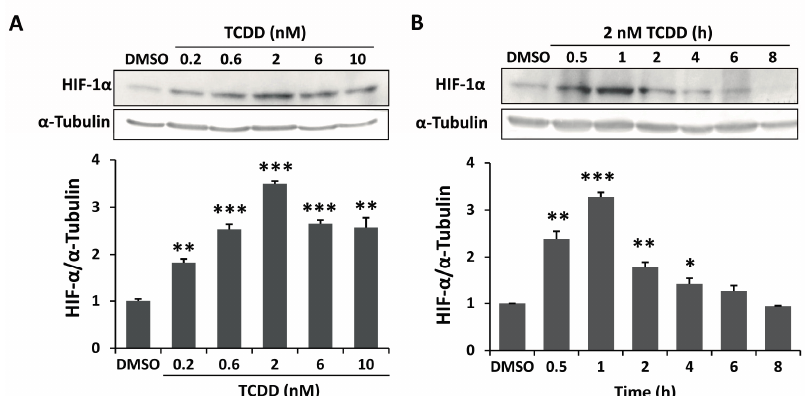
Figure 1. Dose- and time-dependent effects of 2,3,7,8-Tetrachlorodibenzo- p -dioxin (TCDD) on hypoxia-inducible factor-1 alpha (HIF-1 α ) stabilization in human trophoblastic cells. Western blots of a representative experiment were shown. ( A ) Human trophoblastic cells were treated with various doses of TCDD (0.2, 0.6, 2, 6, and 10 nM) for 1 h and immunodetected with an HIF-1 α specific antibody; ( B ) Cells were incubated with 2 nM TCDD for various time periods (0.5–8 h); ( C ) Cells were pretreated with α -naphthoflavone ( α -NF) (Aryl hydrocarbon receptor (AhR) antagonist) for 24 h. TCDD-induced HIF-1 α stabilization was attenuated by pretreatment of the cells with α -NF (1, 5, and 10 μ M). The mean densitometry data from independent experiments were normalized to the results obtained for cells in the absence of TCDD (as control group). DMSO (0.1% v / v ) alone was used as the solvent control. The plots are presented as the mean ± standard deviation (SD) ( n = 3). * p < 0.05; ** p < 0.01; *** p < 0.001 compared with the control group. ## p < 0.01 compared with the 2 nM TCDD-treated